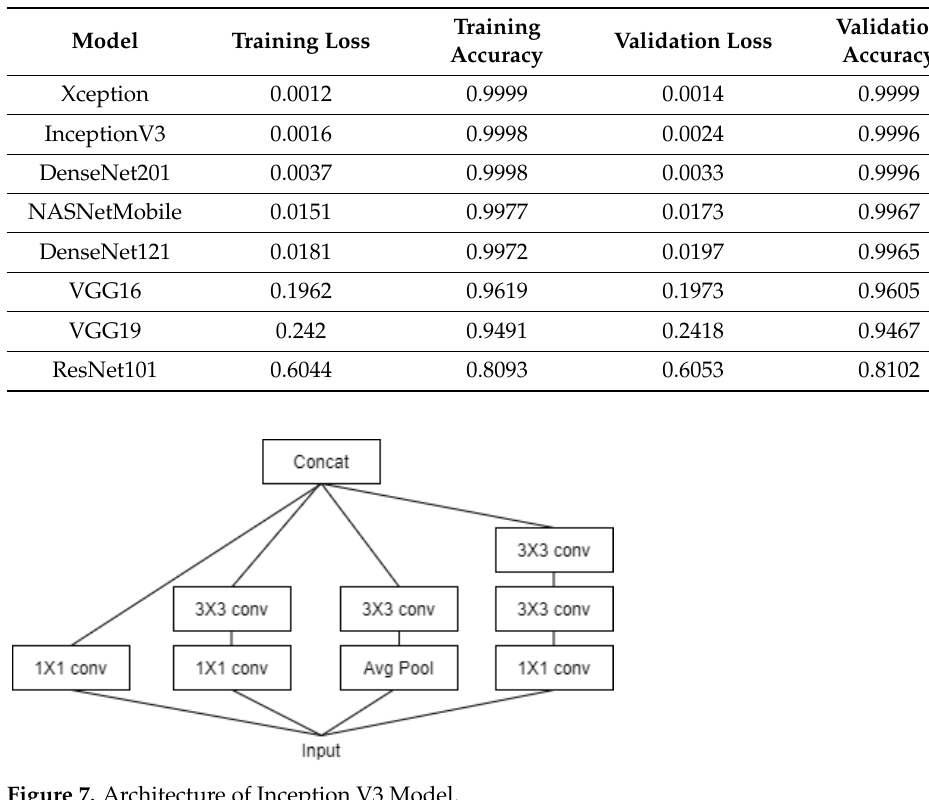
Figure 6. Flow diagram of activating function from ‘Softmax’ .